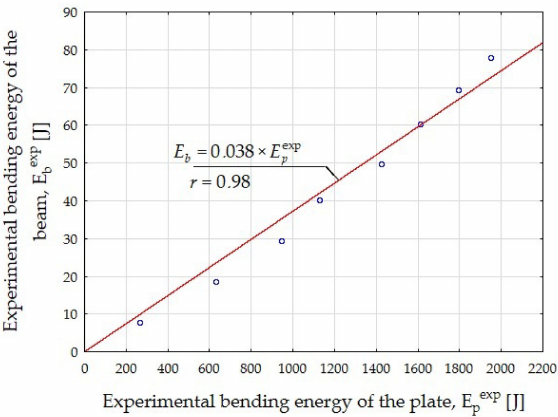
Figure 13. The relation between the experimental bending energy of the beam E bexp and the experi- mental bending energy of the plate E pexp .